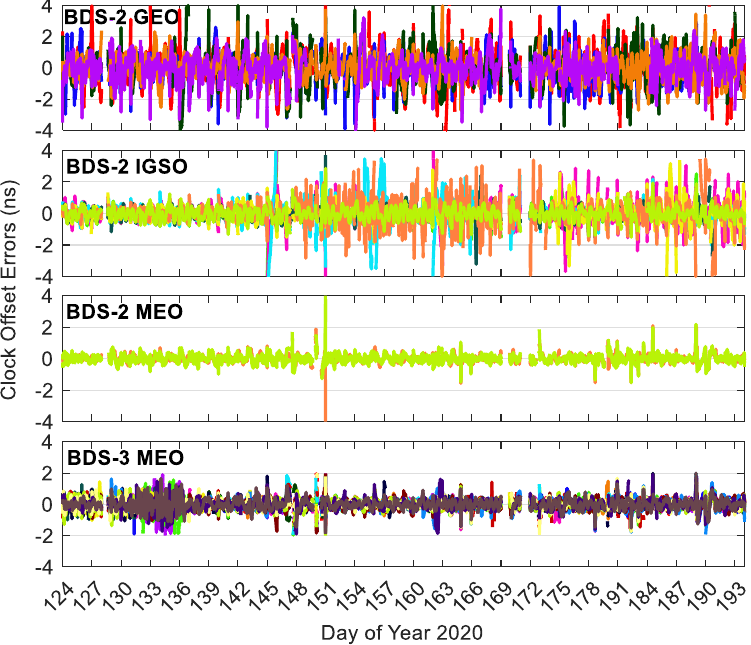
Figure 11. Errors of BDS-3/BDS-2 precise satellite clocks in the real-time situation. Different colors in the figure refer to different satellites.